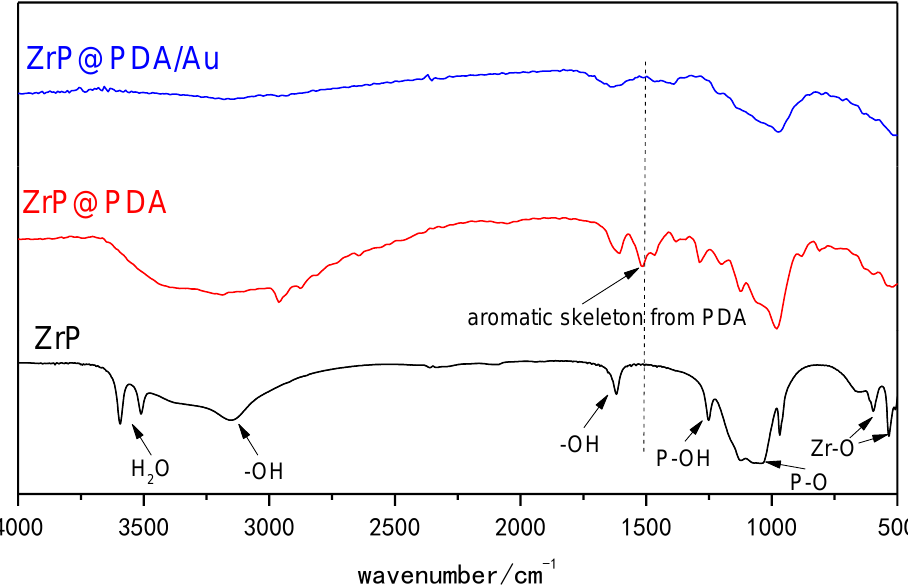
Figure 5. FTIR spectra of ZrP, ZrP@PDA, and ZrP@PDA/Au samples.